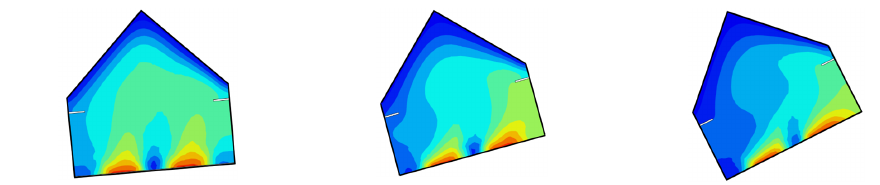
Figure 5. Particle trajectories ( a ), iso-contours of concentration ( b ) and temperature ( c ) for N = 0 and z = 0.5 (case 0).